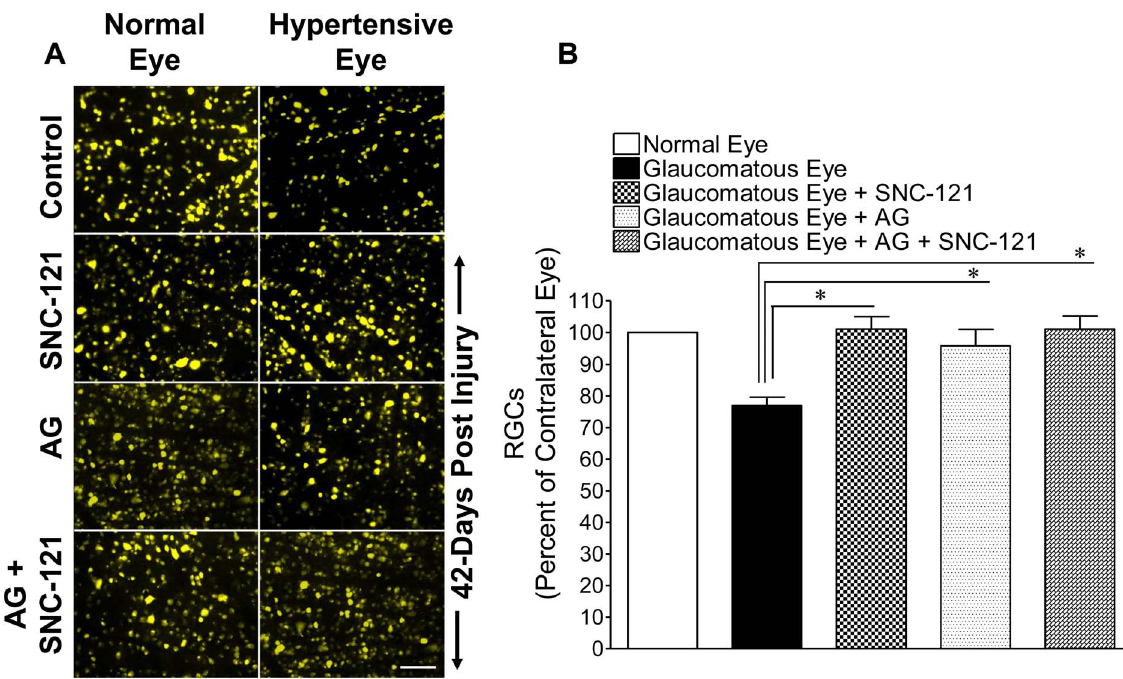
Figure 3. Retina flat mounts of normal and glaucomatous eyes. Fluorescence micrographs of flatmounted retinas depicting Fluorogold- labeled retina ganglion cells (RGCs) in normal and glaucomatous eyes in the absence or presence of drugs ( A ). Briefly, 3 m L of a 5% solution of Fluorogold was injected into the superior colliculus of anesthetized animals. Seven days post injection, animals were euthanized and retinas were prepared as flatmounts, vitreous-side facing up. Fluorescent RGCs were visualized under Zeiss microscopy. Bar=20 m m. Total RGC tallies in glaucomatous eyes in the absence or presence of drugs. RGCs were counted in 8 microscopic fields of identical size (150 m m 2 area) for each retina, using Image J software ( B ). * P , 0.05; n=6 for each